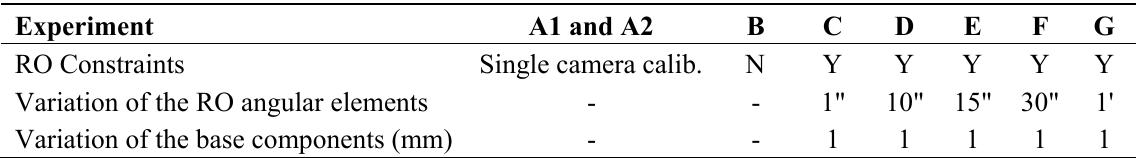
Table 2. Characteristics of the seven experiments with real data. Experiment